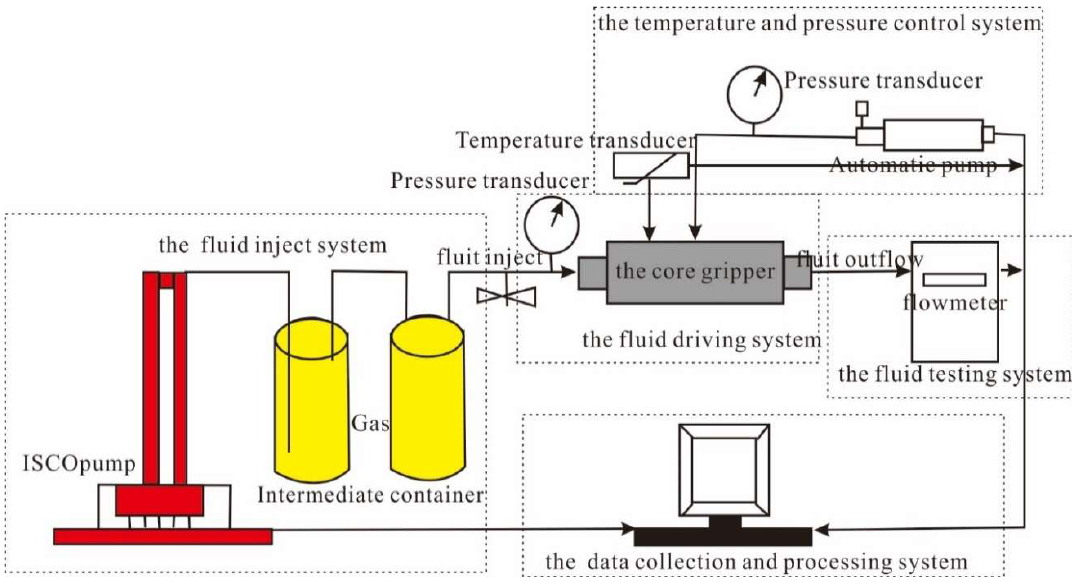
Figure 3. The simulation experiment set of gas migration and accumulation.